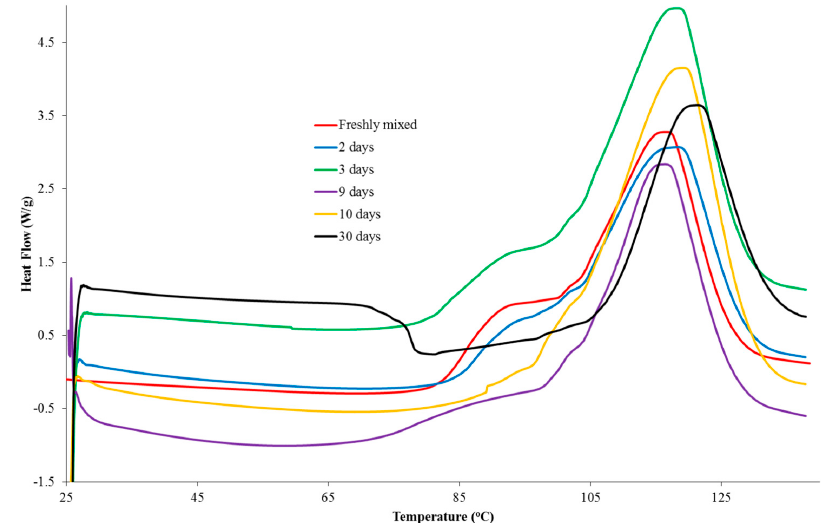
Figure 10. Comparison of the dynamic DSC data for freezer-stored formulations of PGE (5 g) and 1- ethyl-3-methylimidazolium acetate (0.25 g) as a function of storage time. 1-ethyl-3-methylimidazolium acetate (0.25 g) as a function of storage